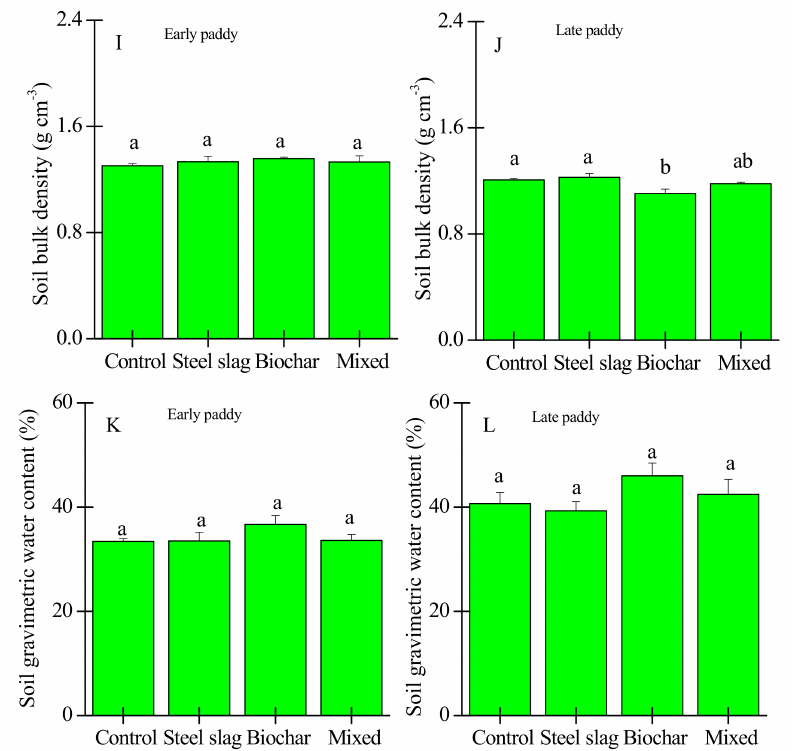
Figure 5. Mean soil salinity ( A , B ), pH ( C , D ), N concentration ( E , F ), C:N ratio ( G , H ), bulk density ( I , J ), and gravimetric water content ( K , L ) in the treatment and control plots in the early and late paddy fields. Different letters represent significant difference in mean values among treatments ( p < 0.05, n =